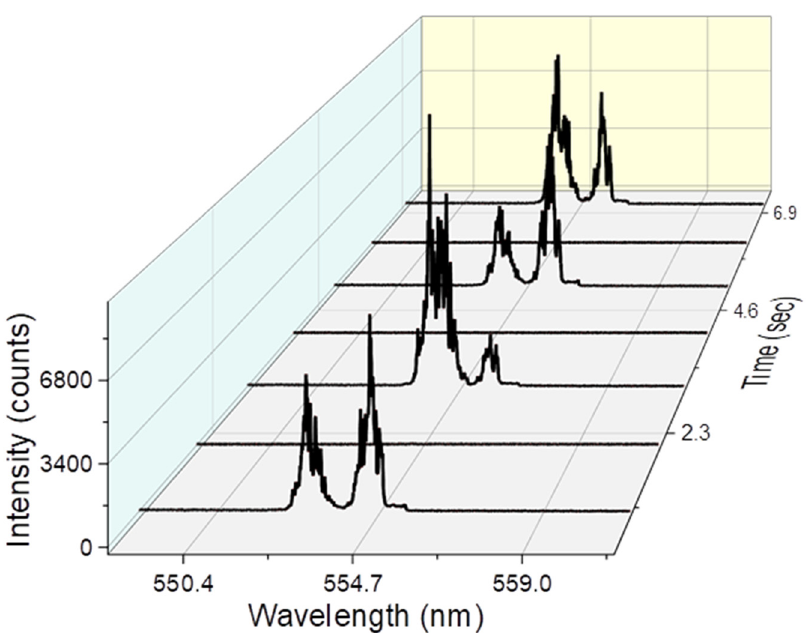
Figure 4. Laser emission from the OFRR as a function of time when alternating microdroplets of the target and the base mismatched DNA are introduced. Note that the optical signals from the target and base mismatched DNA are clearly distinguished. Thus, our platform allows for sequential analysis of individual microdroplets of different DNA samples.